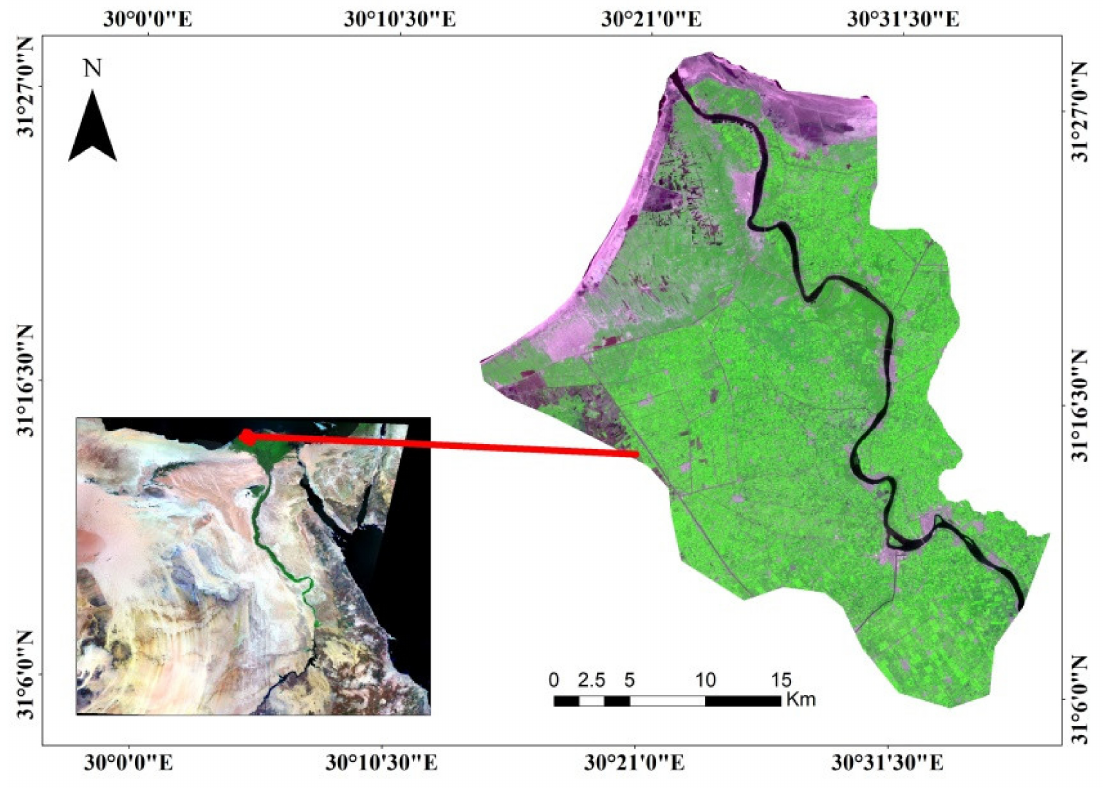
Figure 1. Location of investigated